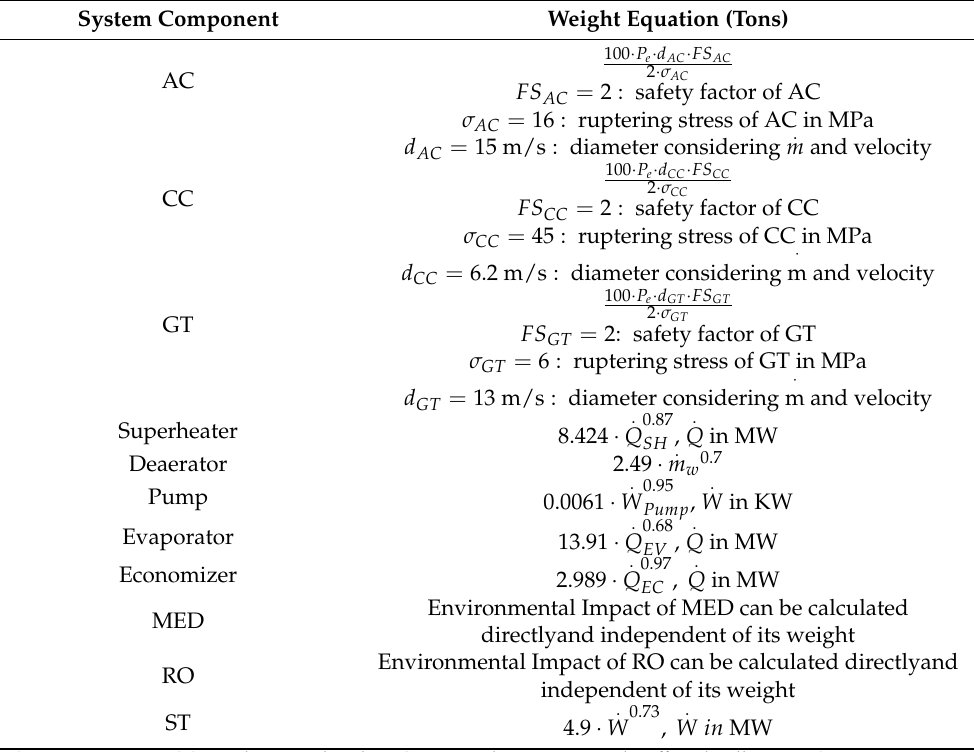
Table 5. Weight function associated with each system component [25].